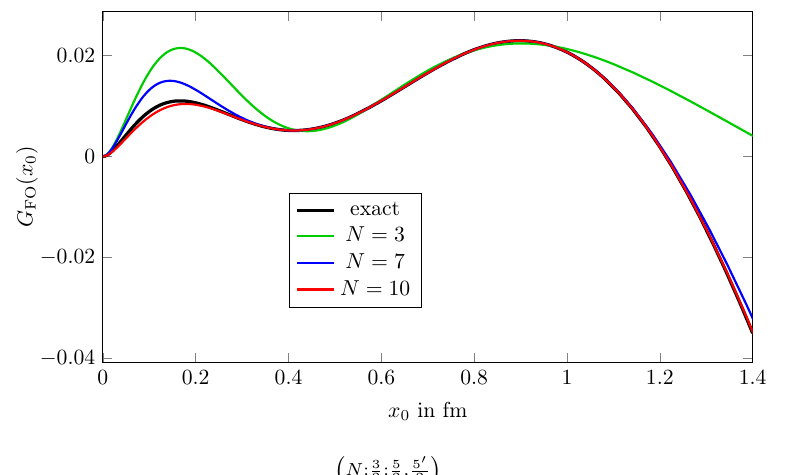
Figure 11 . Shape of the Approximants G (blue) and N = 10 (red). The model function G model approach is in